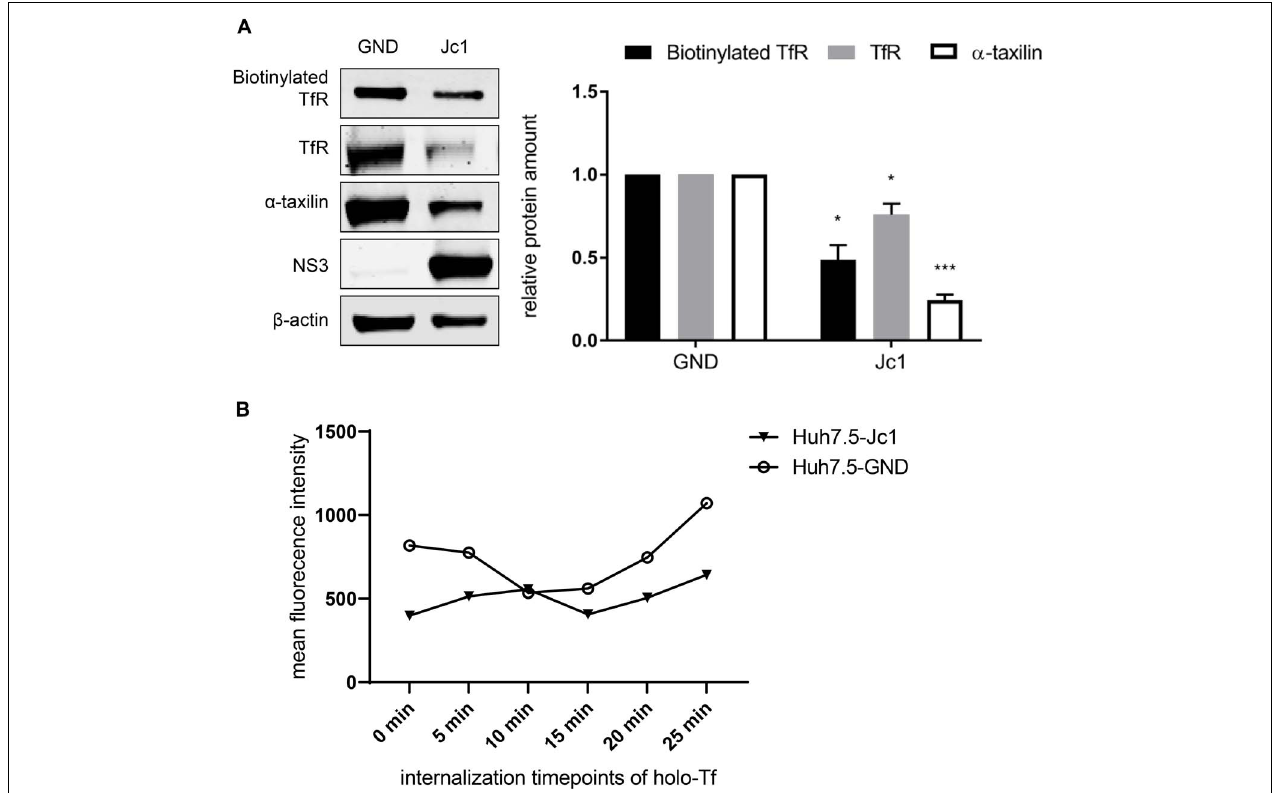
FIGURE 5 | Reduced amount of TfR on the cell surface in HCV-replicating cells. (A) (Left) Western blot analysis of a biotinylation assay of cellular lysates derived from HCV-positive (Jc1) and HCV-negative Huh7.5 cells (GND). For biotinylation of surface proteins, the cells were treated with the non-membrane permeable activated biotin derivate EZ-link-sulfo-NHS-SS-biotin 72 hpe for 30 min, followed by precipitation with PierceTMNeutrAvidinTM agarose beads. Precipitated surface TfR was detected using a TfR-specific antibody and compared the total lysate of the corresponding cells. For detection of the total lysate, TfR-, α - taxilin-, and NS3-specific antibodies were used. ß-actin served as a loading control. (Right) Densitometric quantification of the biotinylated-TfR, the TfR, and α -taxilin in HCV-positive (Jc1) and HCV-negative cells (GND) from two independent experiments. Untreated HCV-negative cells (GND) served as a control and were set as 1 ( n = 2 experiments; mean ± SEM). * p < 0.05, *** p < 0.001. (B) Mean fluorescence intensity of Huh7.5 electroporated with Jc1 or GND. After loading with holo-transferrin, cells were harvested an the amount of TfR on the cell surface of non-permeabilized cells was determined at different time points using a TfR-specific antibody that binds to the extracellular domain. The antibody was visualized by an Alexa488 conjugated secondary antibody and the analysis was performed by flow cytometry. One representative experiment is